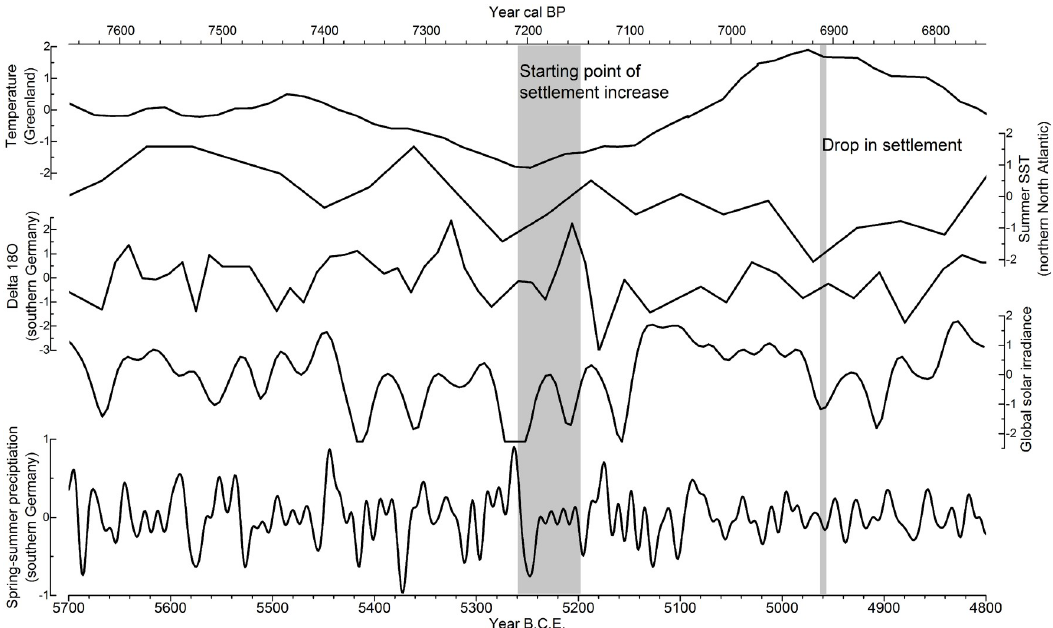
Fig 7. Climate variability during the LBK. Reconstructions of Greenland temperature [65], summer sea surface temperature in the northern North Atlantic [66], delta 18 O in southern Germany [67], global solar irradiance [68] and precipitation (5-year lowpass filtered) for the Main region (southern Germany) from tree-ring